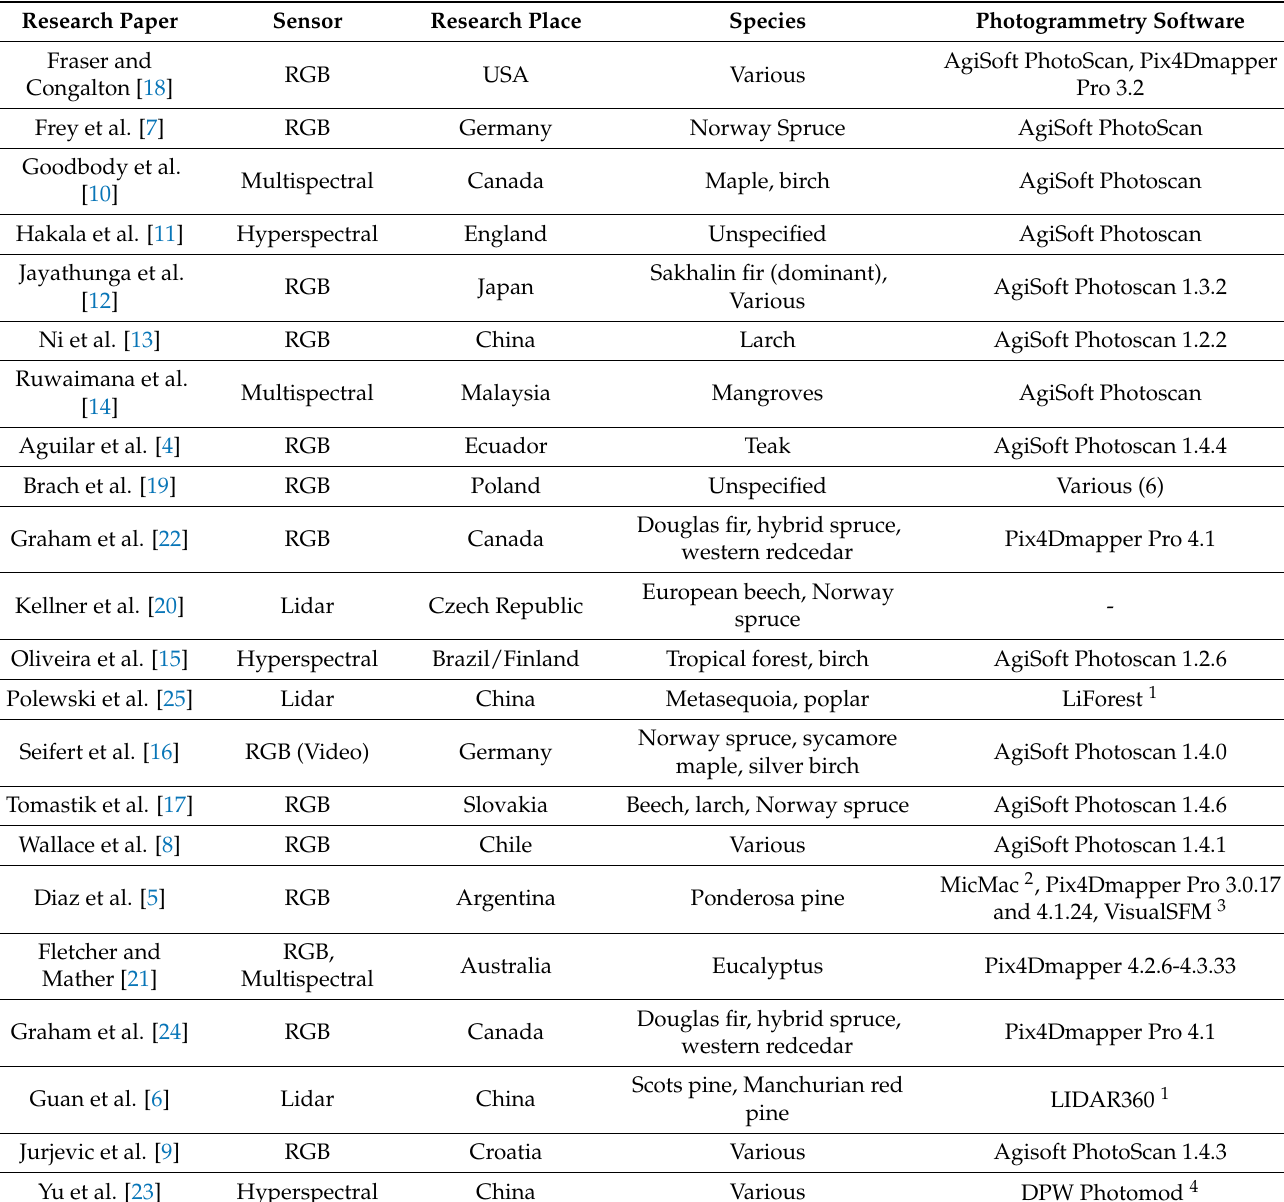
Table 1. Reviewed studies for setting and accuracy of imagery products topic: sensor, research place, tree species, and photogrammetry